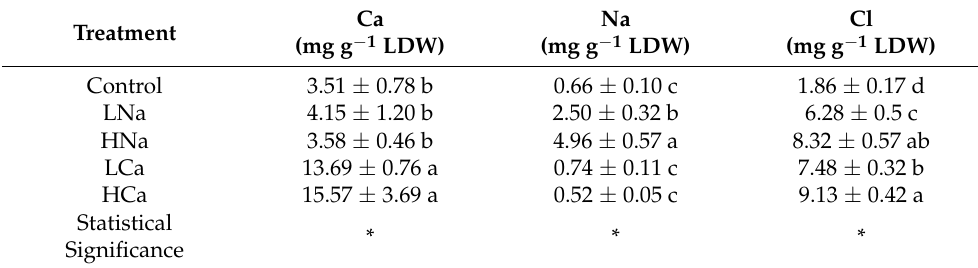
Values represent means ± standard error of three replicates. Means within the same column followed by different letters indicate significant differences according to Duncan’s multiple range test ( p < 0.05): * indicates significance Plants 2023 , 12 , x FOR PEER REVIEW at p < 0.05.